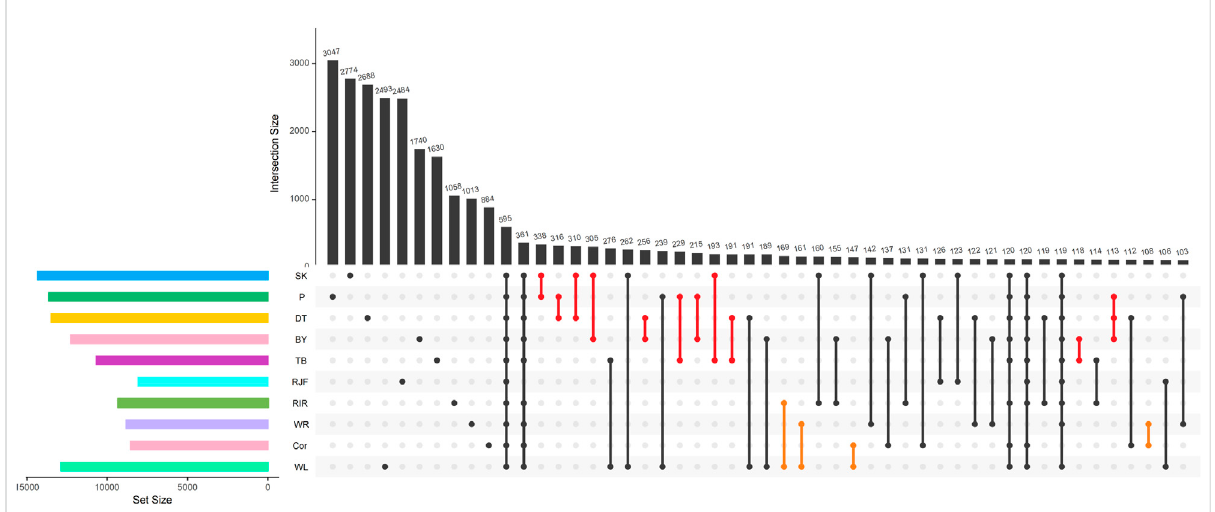
FIGURE 5 UpSetplotofSVsresultsdetectedineachchicken.TheintersectionbetweenAsianchickensisrepresentedbyaverticalredline;theintersection between European chickens is represented by a vertical orange line, the others is represented by a vertical black line. Note: In the upper left, Venn diagram of the same genetic background. In the bottom left panel, horizontal bars represent the number of SVs detected by each chicken, vertical bars represent the size of SVs detected in each chicken, black dots represent the sample set, and the intersection between chickens is represented by a vertical black